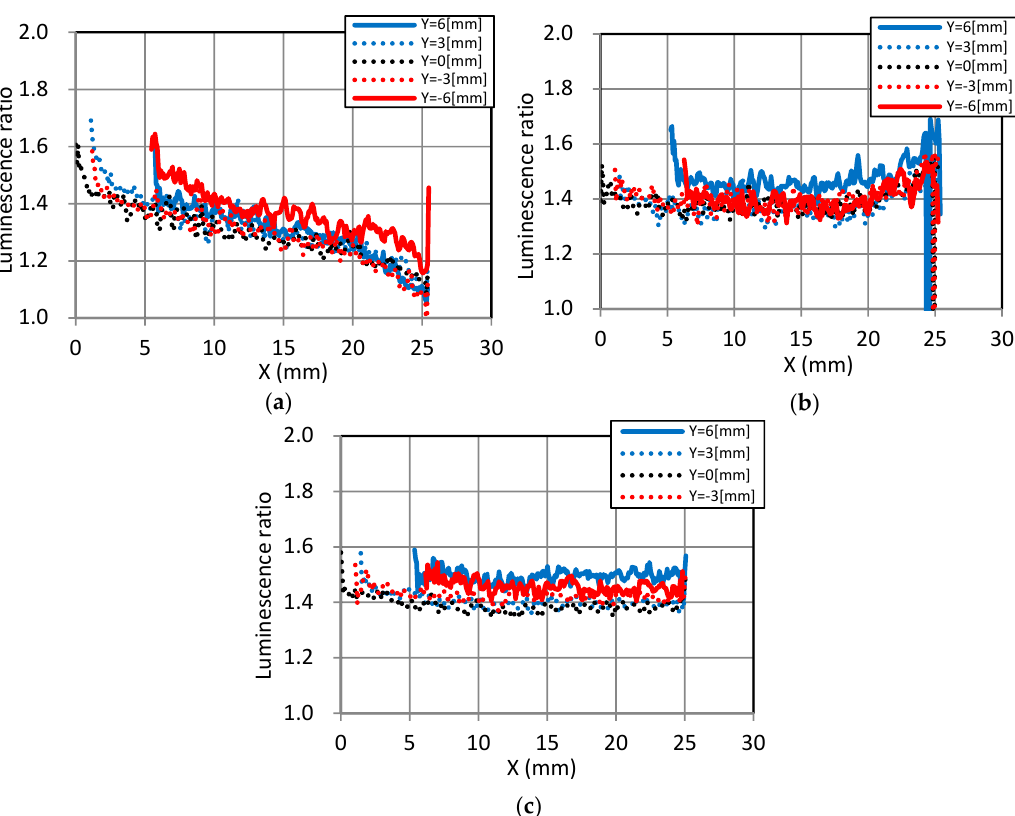
Figure 8. Luminescence ratios along the X-axis (longitudinal direction). ( a ) Static dipping; ( b ) Convectional dipping; ( c ) Rotational dipping.